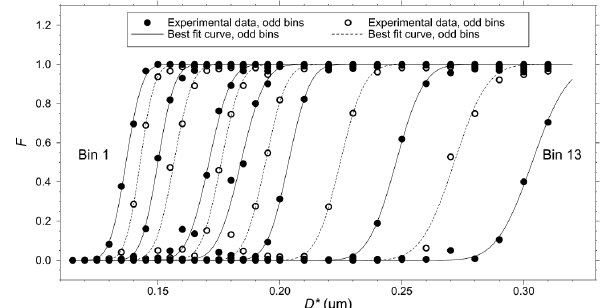
Fig. 5. Particle size distributions measured during a scanning cali- bration of a PCASP using a DMA. Each bin is normalised by divid- ing by its width. The resolution here is not as good as in Fig. 3, as the bin boundaries used here are those for normal use so no zoom- ing in is applied. Only data collected by the mid gain stage is shown. The labels indicate the mode diameter, D ∗ , set on the DMA when generating each distribution. Peaks can be seen from particles with double charges which pass through the DMA for D ∗ ≤ 0.26µm at pulse heights above approximately 5800. The doubly charged peak at a pulse height of 6300 with D ∗ =0.20 contains more than one third of the total particles in this distribution. These extra peaks must be removed from the analysis to avoid biasing the calibration results.